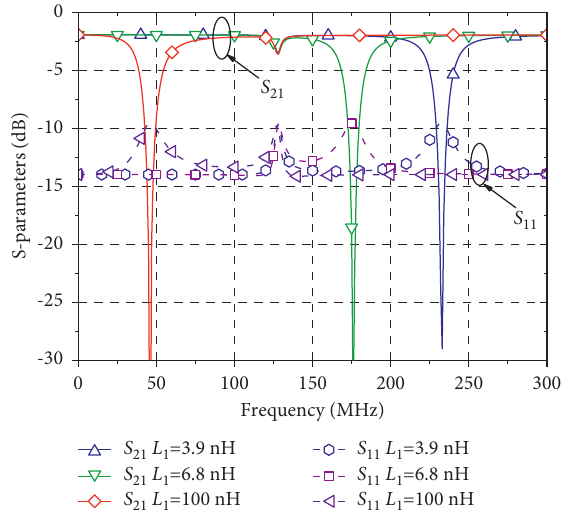
Figure 11: S parameters of band-stop filter with band-pass negative delay at different L